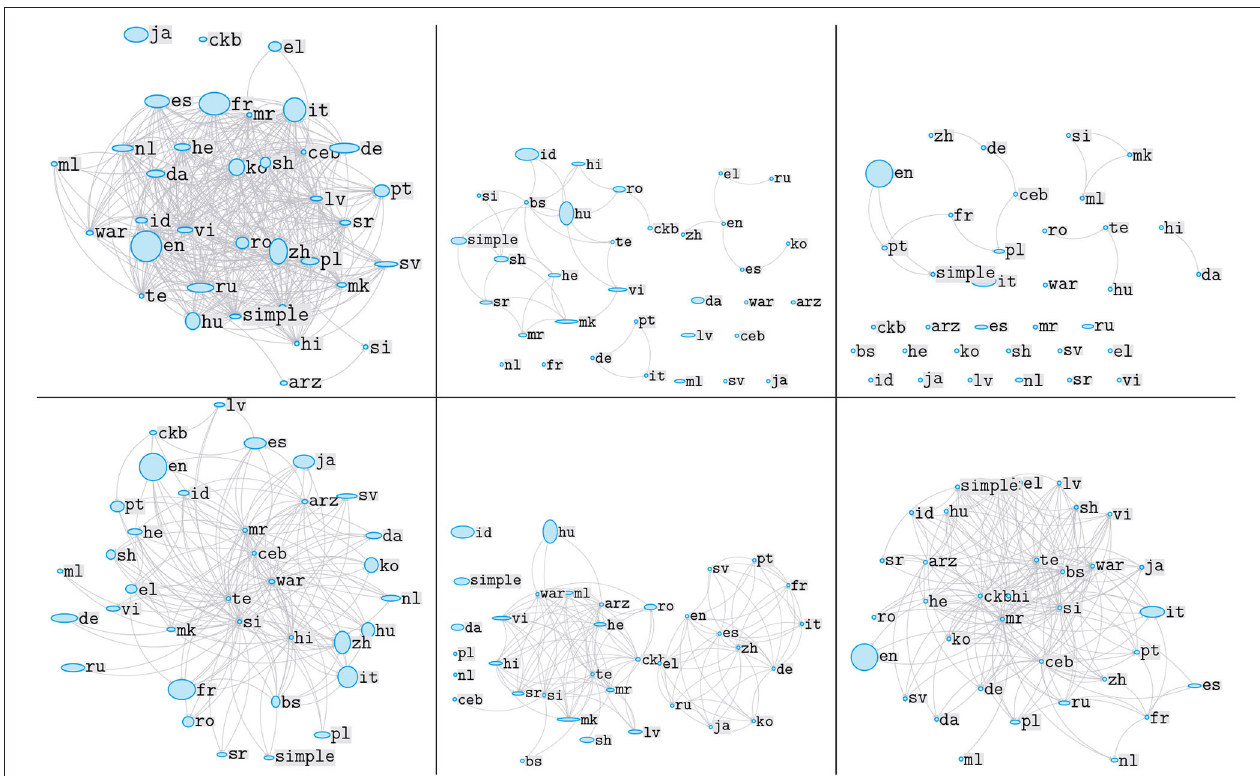
FIGURE 11 | Language networks as a function of above average similarities computed by SV2 (1st row; thematic similarity) and SV4 (2nd row; DeltaCon). First column: subject area composer ; second column: language ; third column: painting . The higher the number of vertices in the underlying IN, the wider the resulting language vertex; the higher the IN’s number of edges, the higher the language